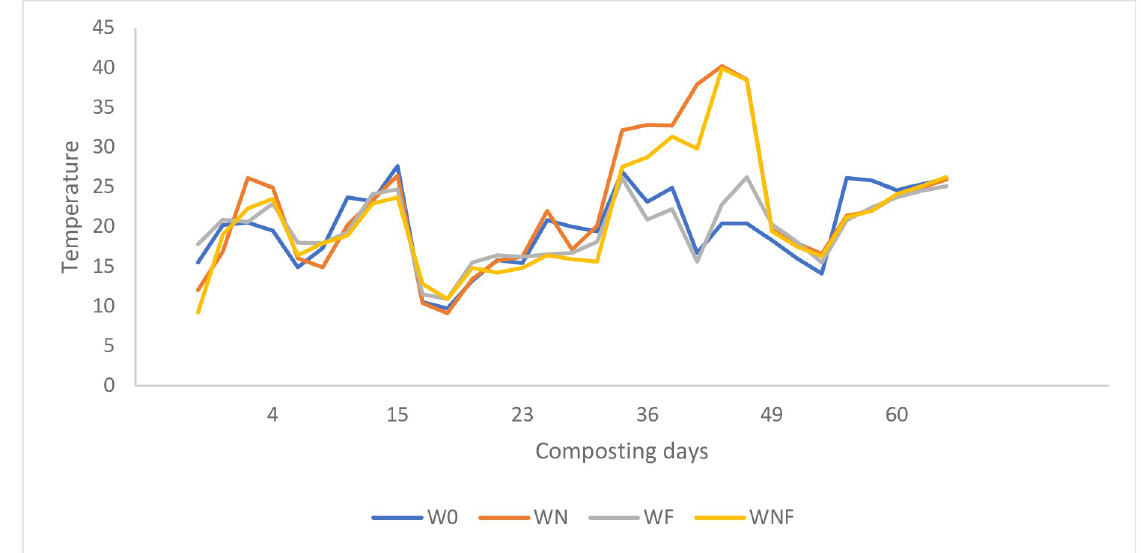
Fig 1. Changes of temperature during composting of willow biomass.